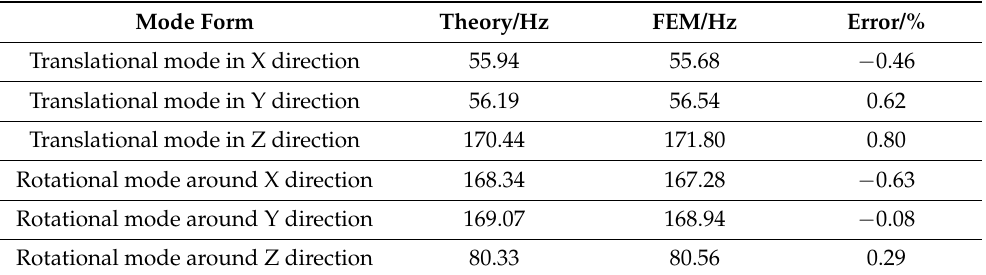
Table 4. Natural frequencies obtained from theoretical calculation and FEM